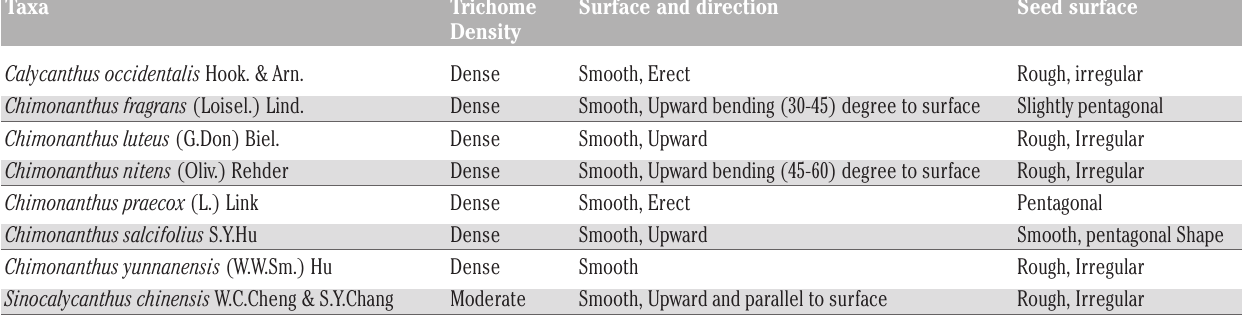
Table 3. Trichome morphology and seed surface in